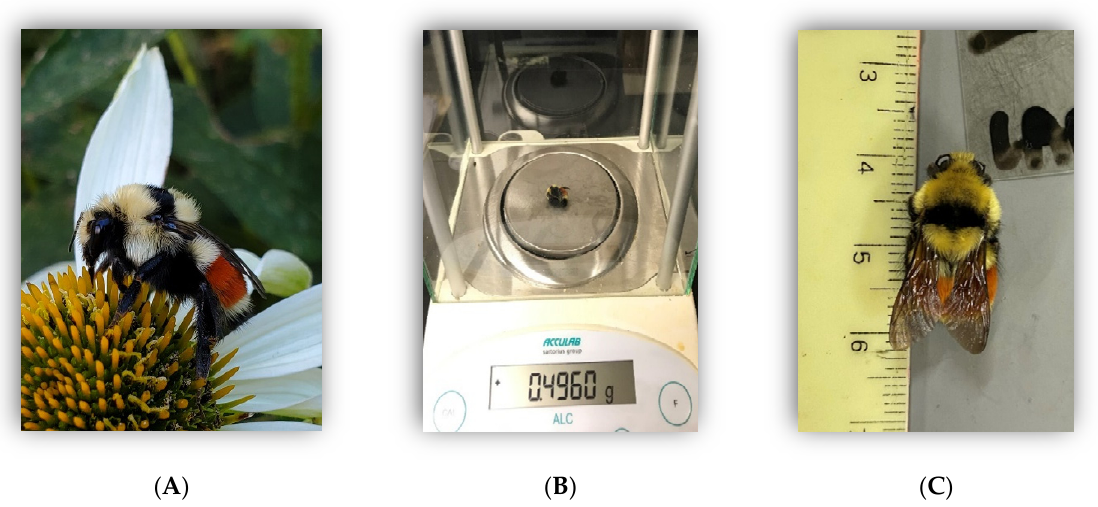
Figure A1. Body condition was determined using non-destructive, classic body metrics. ( A ) Queen B. huntii were captured ( B ) individually weighed, and ( C ) photographed next to an object of a known size to later determine ITW using imageJ.